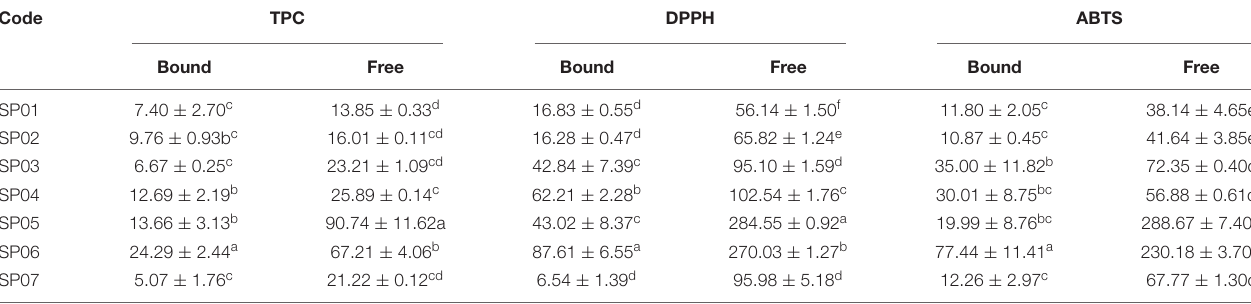
TABLE 1 | TPC, DPPH, and ABTS radical scavenging of free and bound fractions of sweet potatoes. Code TPC DPPH ABTS Bound Free Bound Free Bound Free